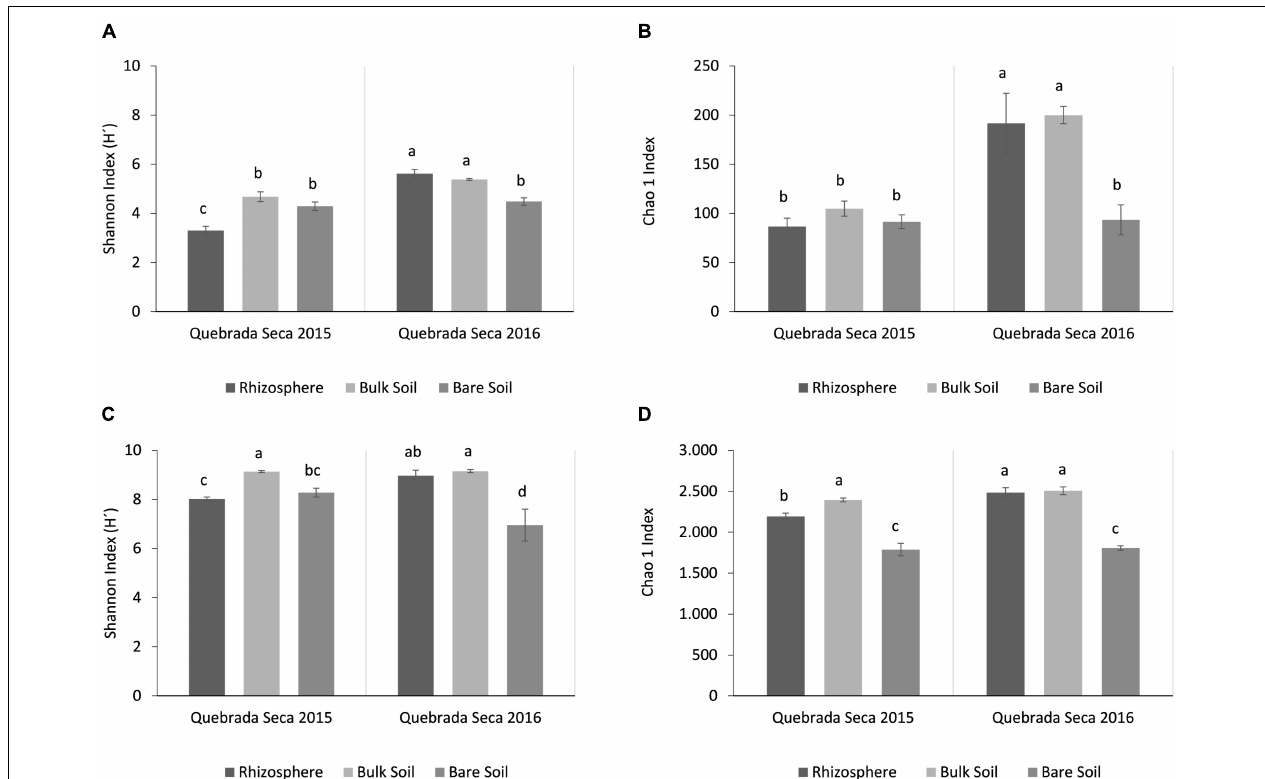
FIGURE 5 | Alpha-diversity analysis per year and sample type (rhizosphere, bulk soil, bare soil). (A) Shannon Index for fungi; (B) Chao1 Index for fungi; (C) Shannon Index for prokaryotes; (D) Chao1 Index for prokaryotes. Different letters above the bars indicate statistically different means (Tukey test, p <